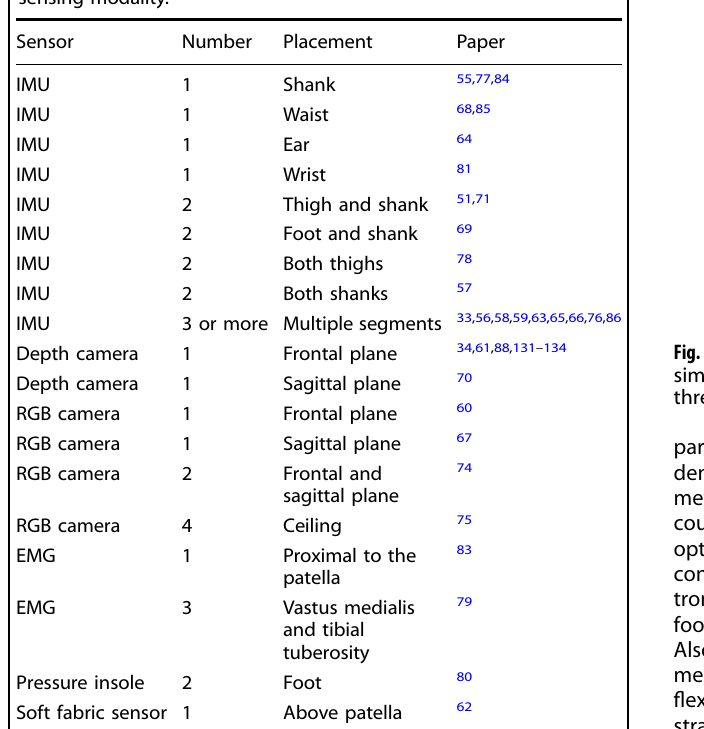
Table 1. Con fi gurations of the included studies that only used one sensing modality.